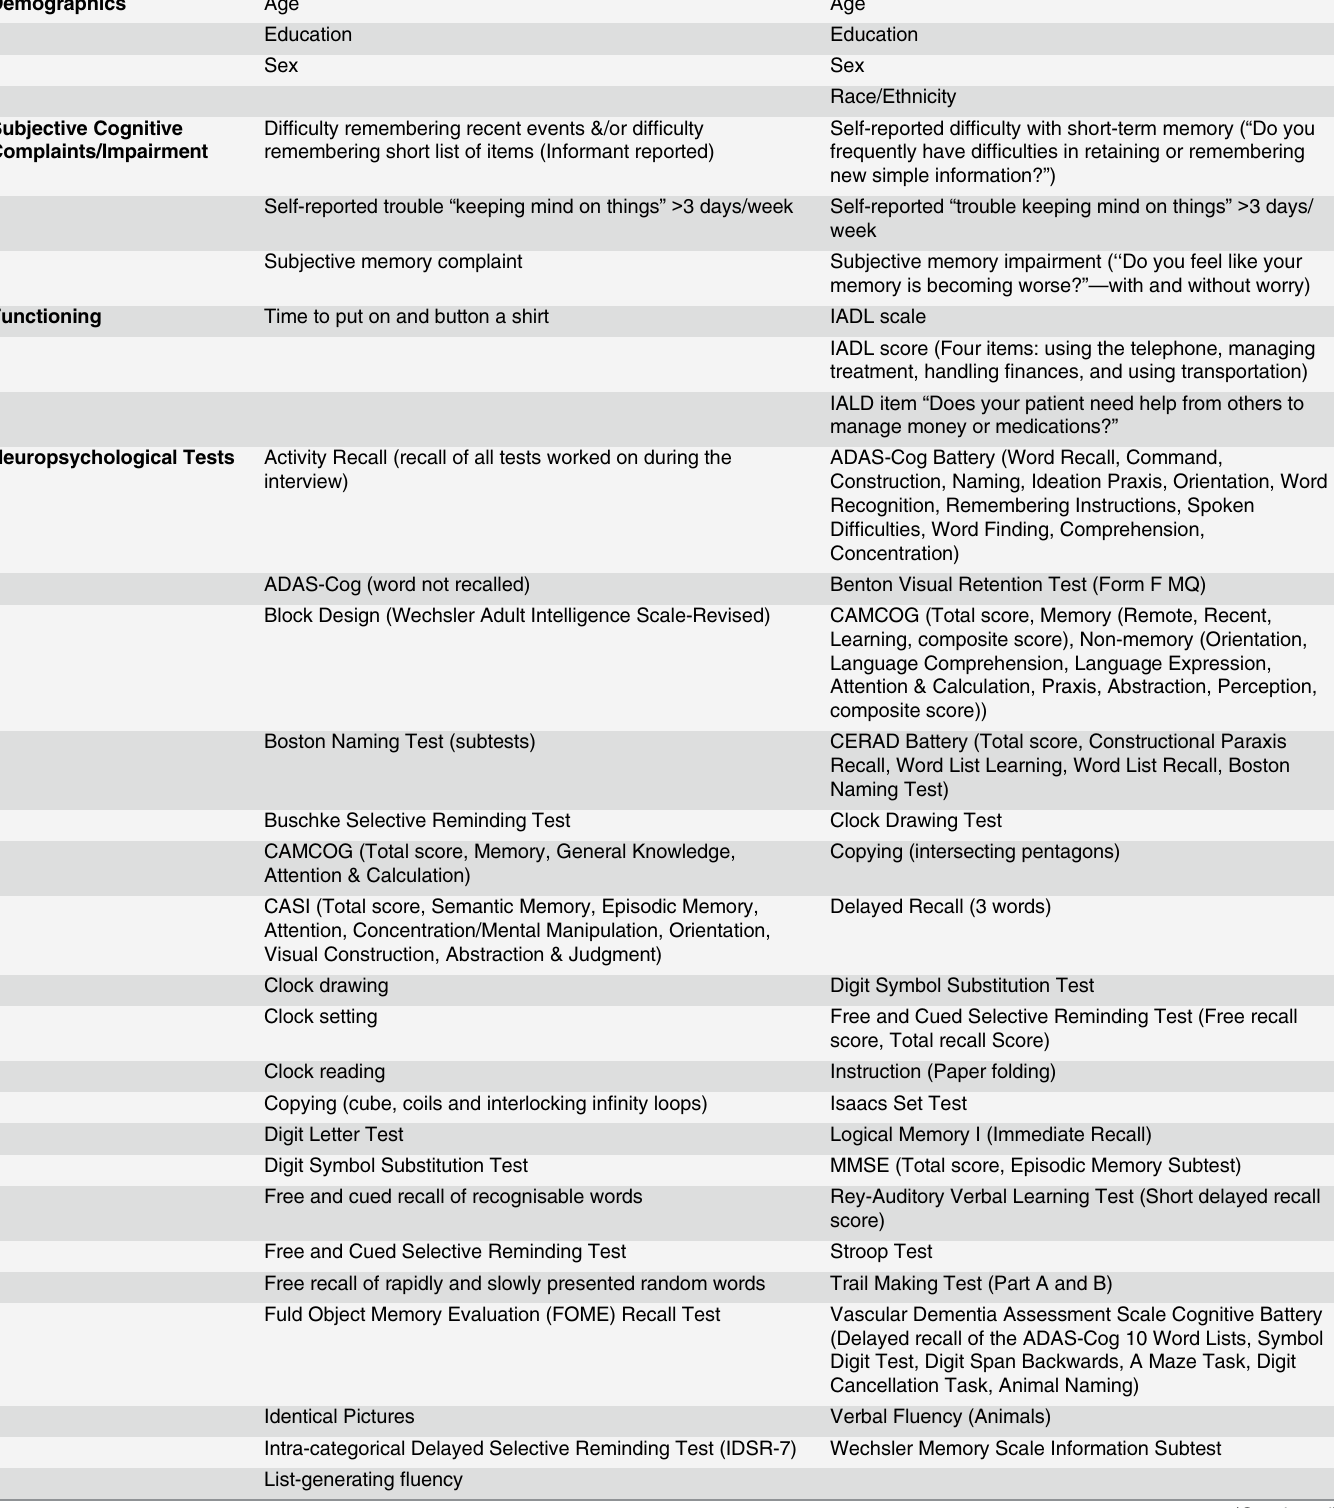
Table 3. Component Variables Used (Either Alone or in Combination) in the Different Risk Prediction Models (Previous and Current Review).